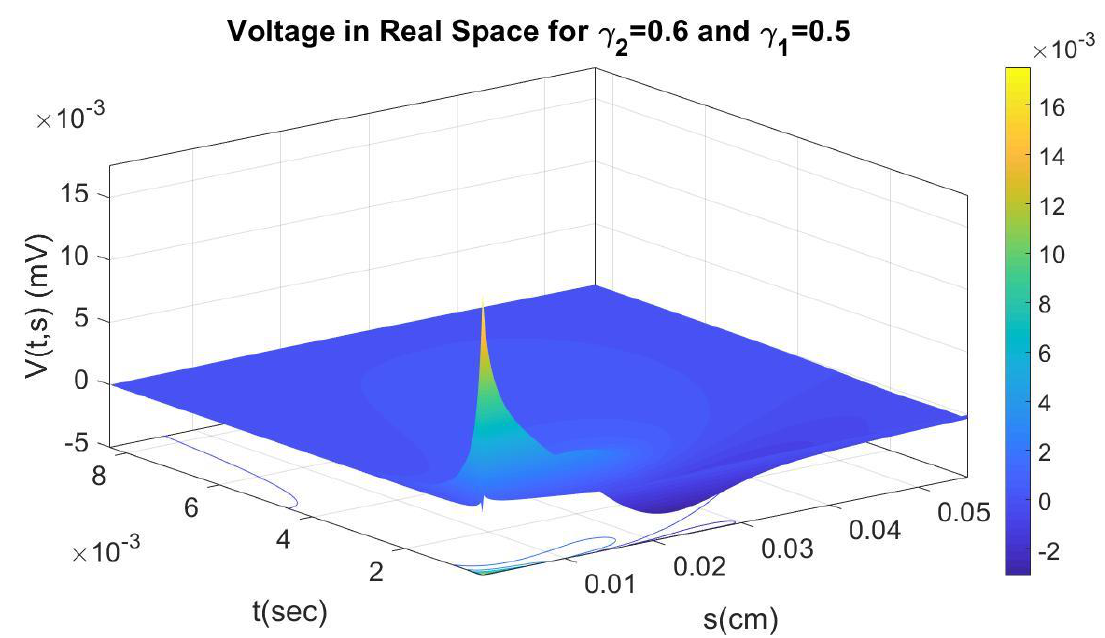
Figure 10. The voltage V(t,s) in real space as a function of time and arc length s, for fractional orders γ 2 = 0.6 and γ 1 = 0.7.